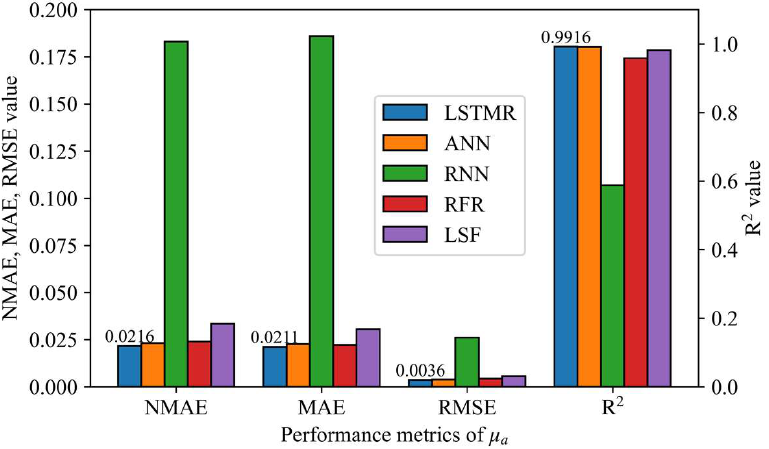
Figure 5. Performance metrics for different models in the phantom experiment for absorption coef- ficient.